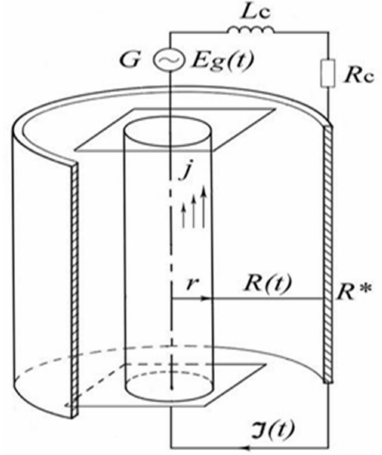
Figure 1. The electrical circuit of the